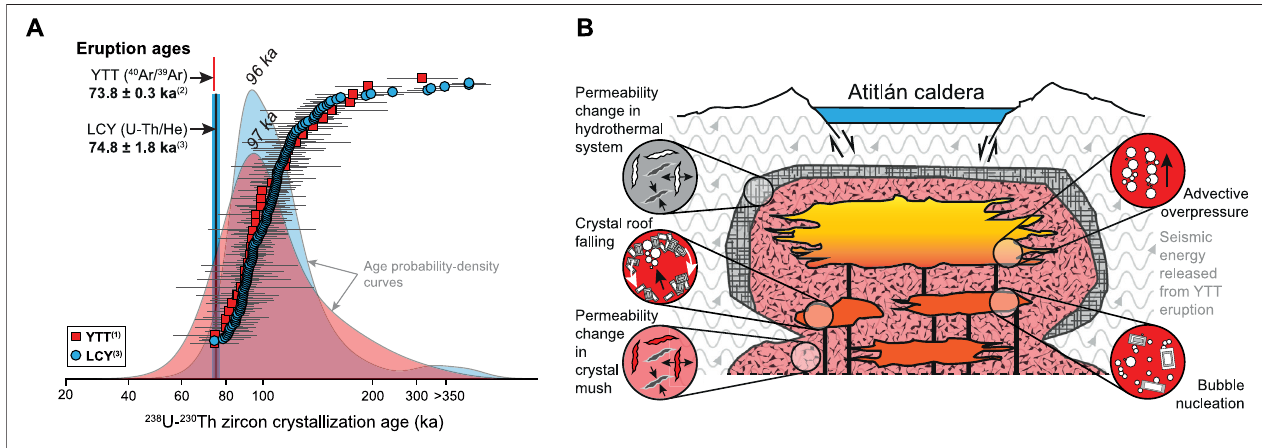
FIGURE 4 | (A) Ranked order plot and probability-density curves for the YTT and LCY zircon rim crystallization ages. Vertical bars represent radioisotopic ages for theYTTandLCYeruptions,withcolored-barthicknessesrepresentingcorresponding1 σ uncertainty.Datafrom 1 Muceketal.(2017), 2 Storeyetal.(2012),and 3 Cisneros deLeónetal.(2021). (B) PotentialYTT-eruption-induced seismic-triggeringmechanismsin fl uencing Atitláncalderasub-volcanicsystempriortotheLCYsupereruption. We propose that these processes may promote new migration pathways or induce instabilities in the magma reservoir and crust ultimately leading to